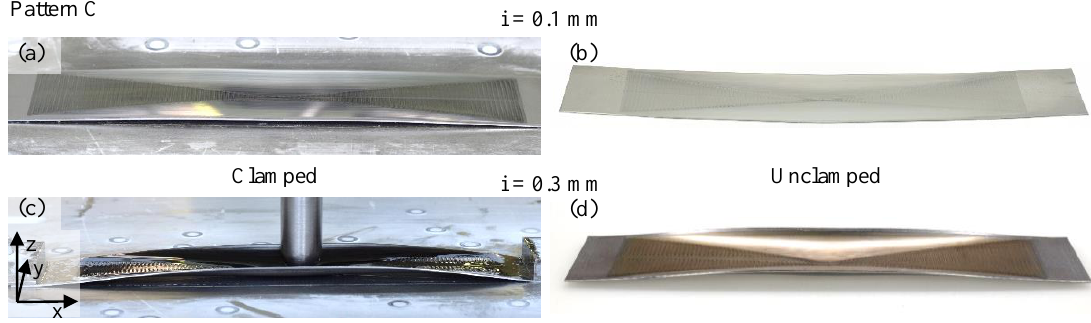
Figure 8. Pattern C: experimental results before (left, ( a ) and ( c )) and after (right, ( b ) and ( d )) unclamping for different intrusion depths i = 0.1 (top, ( a ) and ( b )) and i = 0.3 (bottom, ( c ) and ( d )).